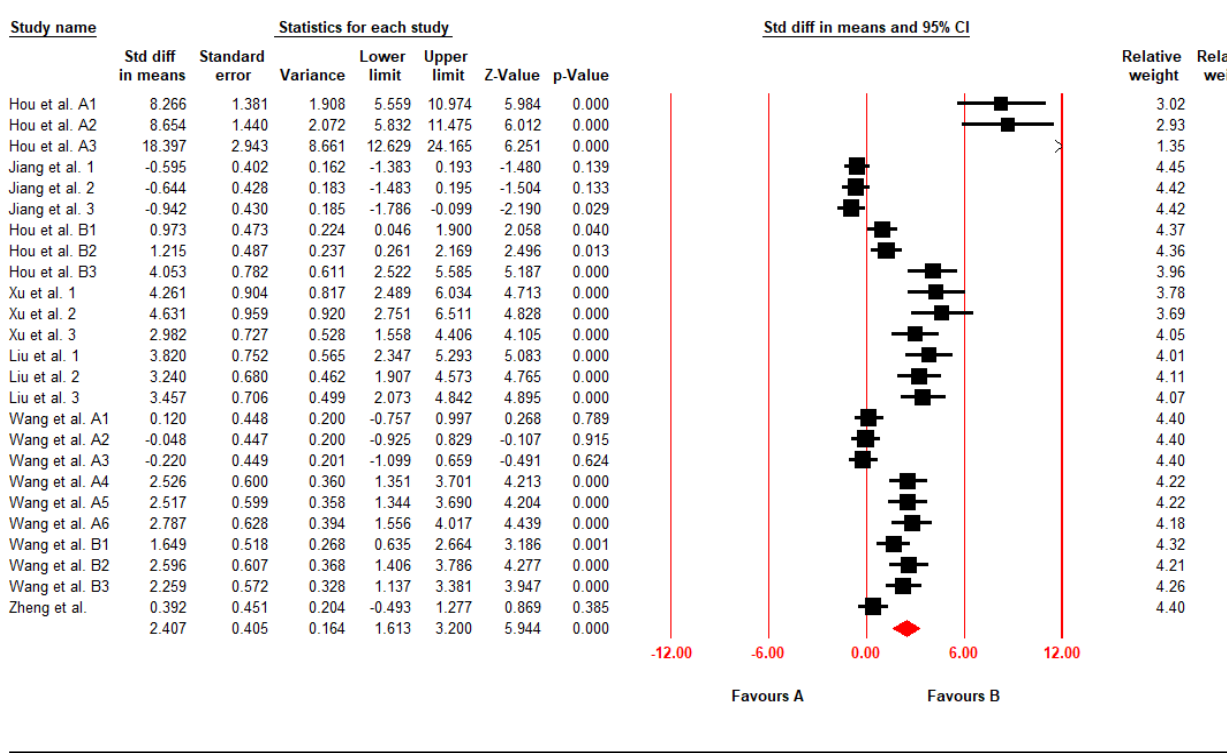
Figure 3. Forest plot of Elevating Serum SOD (SMD, 2.41; 95% CI, 1.61 to 3.20; p < 0.001; I 2 = 91.36%). Black solid square indicated the individual study’s SMD and the red solid square indicated the polling SMD of the included studies.